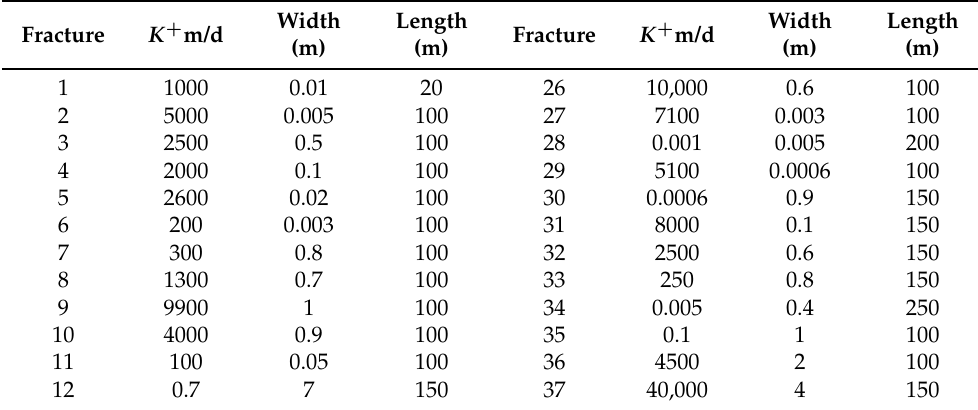
Table 3. Table 3. Parameters defined for Figures 6 and